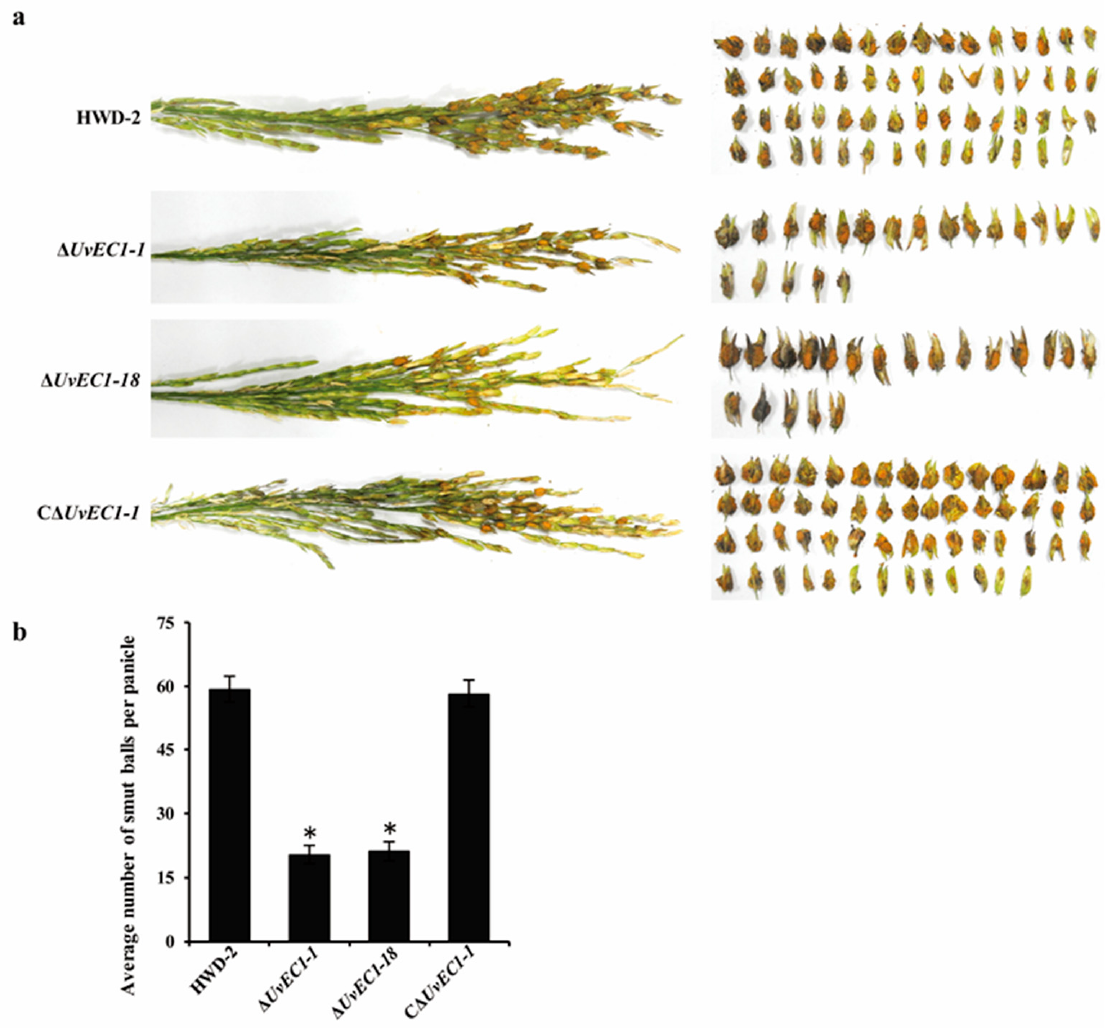
Figure 5. Deletion of UvEC1 affects virulence of U. virens . ( a ) Virulence assays of HWD-2, the ∆ UvEC1 mutants and the complementation strain on rice spikelets (cv. Wanxian98) at 21 days post-inoculation (dpi). Left, entire panicles; right, individual spikelets from an infected panicle. ( b ) Average numbers of smut balls per panicle. Asterisks represent significant differences relative to HWD-2, as determined by LSD at p = 0.05.